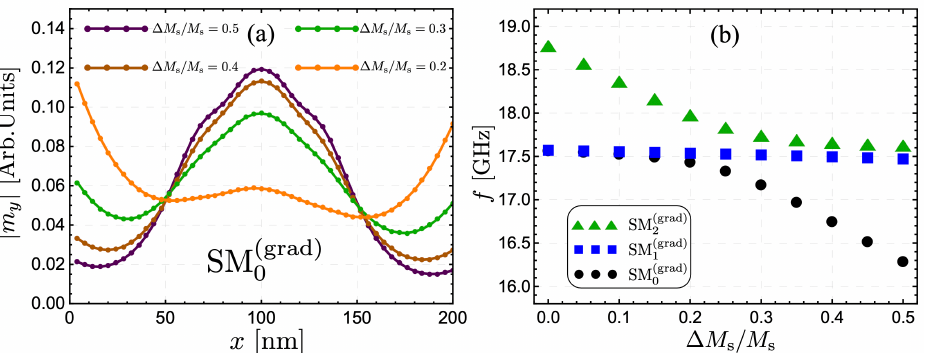
Figure 4. ( a ) The absolute value of the out-of-plane dynamic magnetization component, for mode ( grad ) SM , as a function of x is shown for w = 200 nm and ξ = 100 nm. Different values of the 0 fractional reduction of the saturation magnetization, ∆ M s / M s , have been accounted for. ( b ) The ( grad ) = 0, 1 and 2) is illustrated as a function of ∆ M s / M s for frequency of the modes SM ν (with ν k z =